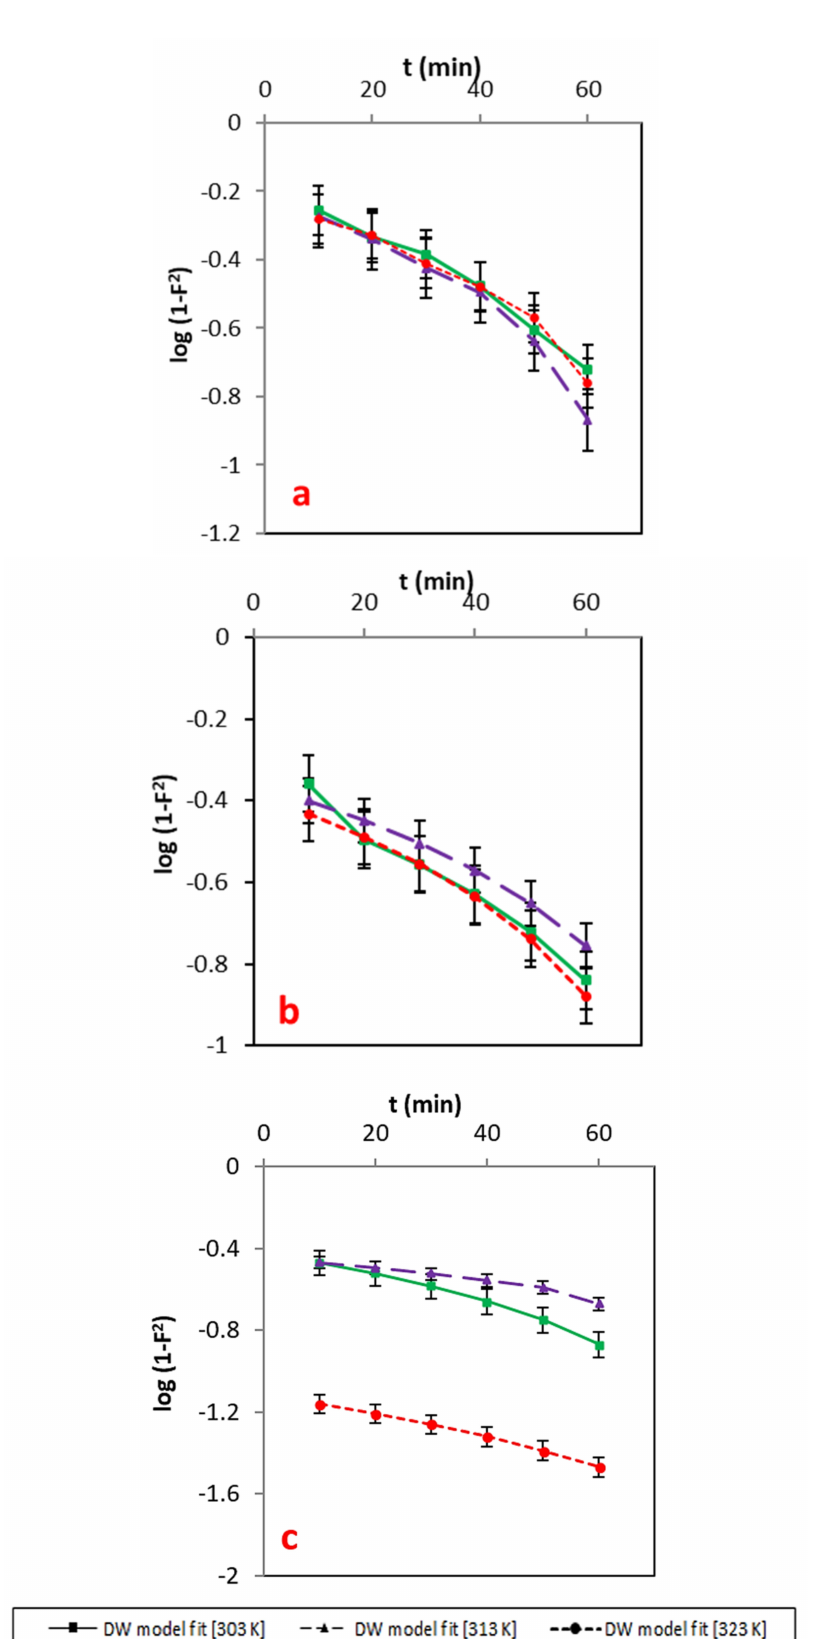
Figure 11. ( a – c ) : Energy information fitted to the Dumwald–Wagner model at different